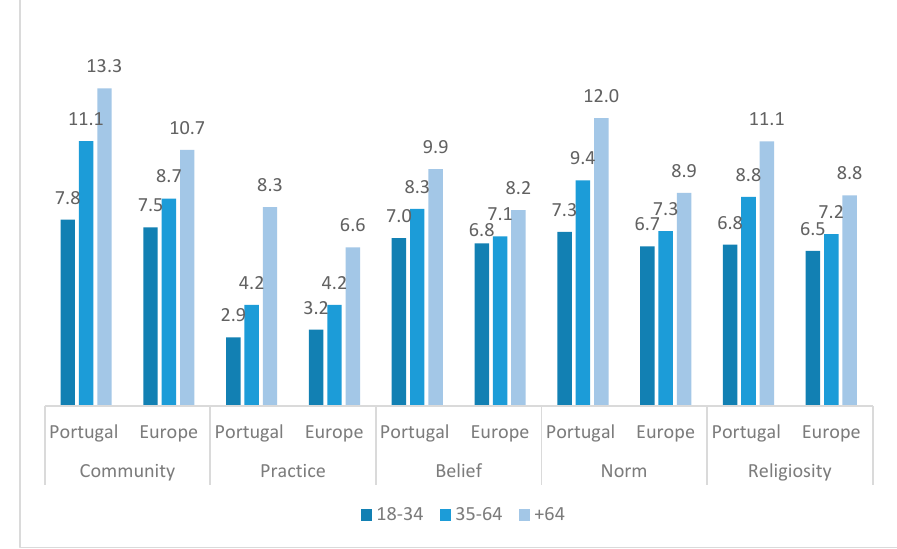
Figure 3. Indexes of Portugal and Europe by age group in 2020. Source: EVS (2021) . Notes: Indexes (Portugal/Europe) vary between 0 and 16. Significant differences exist between all age groups in Portugal and in Europe in all indexes except in belief in Europe where there are no significant differences between 18–34 and 35–64. Tests: Community—Portugal—Fw (2) = 65.565, p < 0.001;